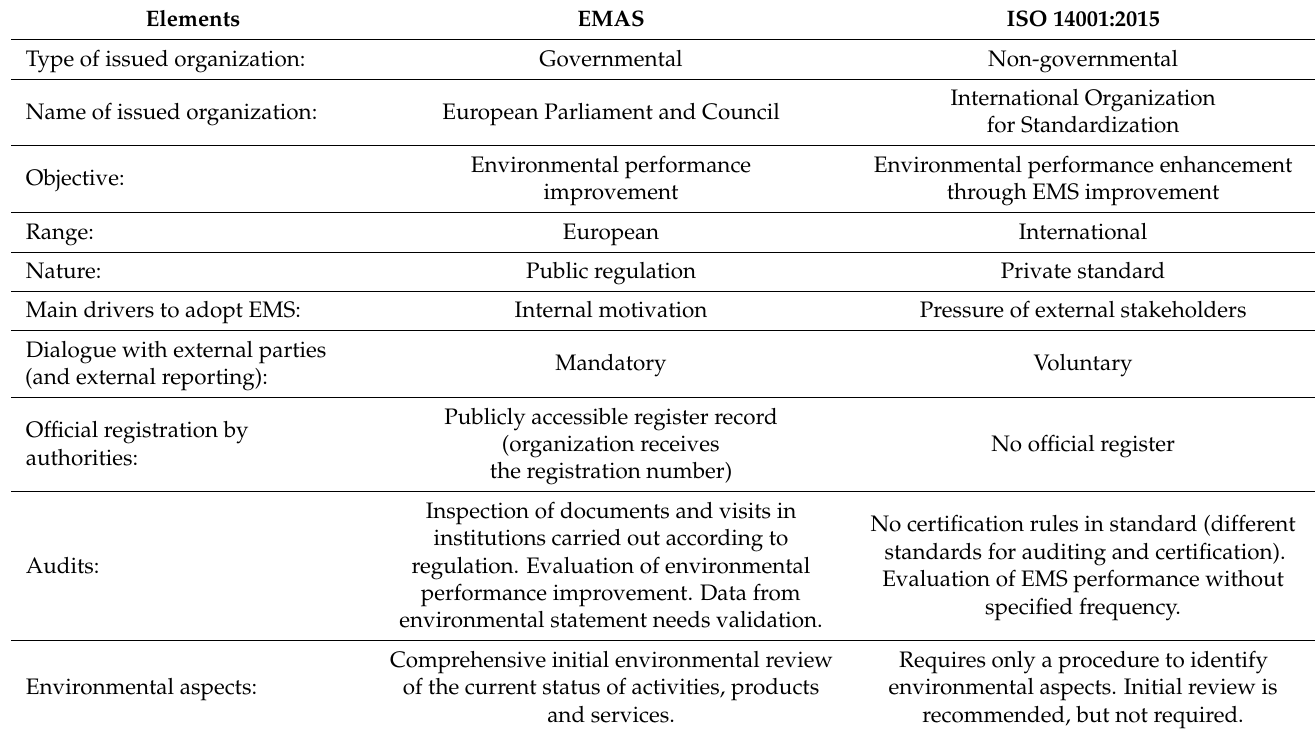
Table 1. Selected differences between EMAS and ISO 14001:2015. Source: Own elaboration based on [36–40]. Elements EMAS ISO 14001:2015 Type of issued organization: Governmental